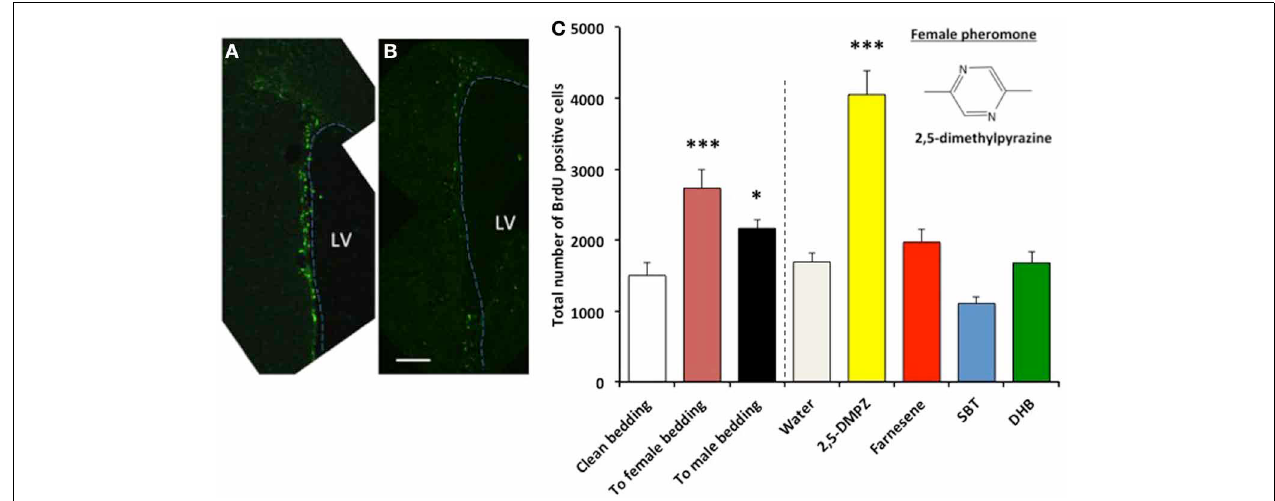
FIGURE 5 | Influence of exposure to female and male mouse pheromones on cell proliferation in the SVZ of male mice. BrdU + cells (green fluorescence) in the SVZ of males exposed to 2,5-DMPZ (A) or clean bedding (B) . LV: lateral ventricle. Dashed line indicates the border of lateral ventricle. Scale bar = 100 μ m. (C) Male mice exposed to female mouse pheromone 2,5-DMPZ ( n = 6) showed enhanced cell proliferation in the SVZ